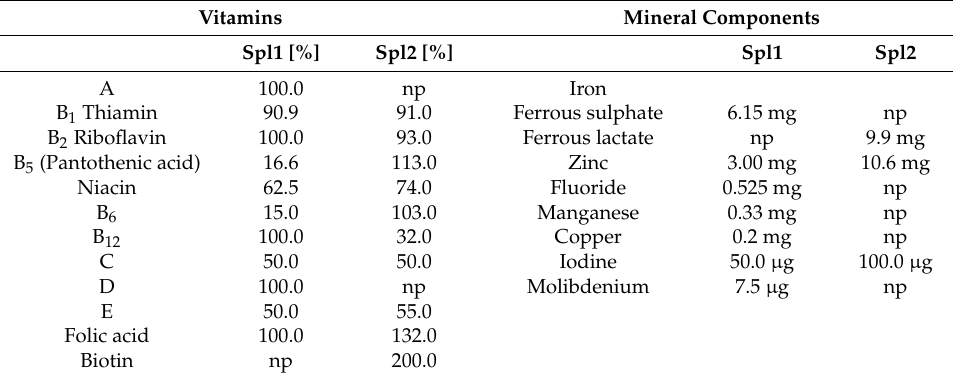
Table 1. Composition of dietary supplements (Spl1 and